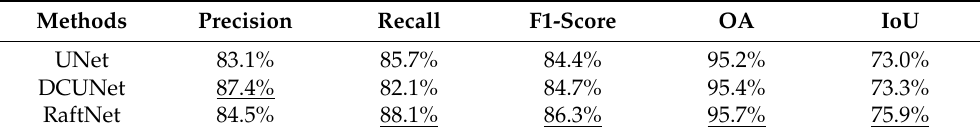
Table 5. Accuracy evaluation table of ablative analysis (the best value is underlined).